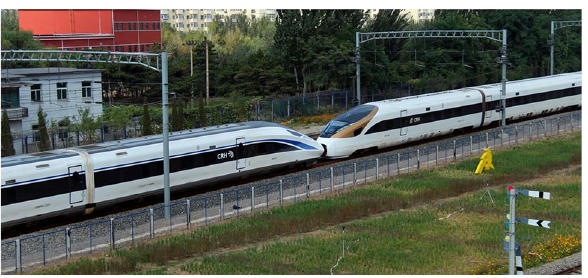
Fig. 13 Illustration of two coupled new-generation